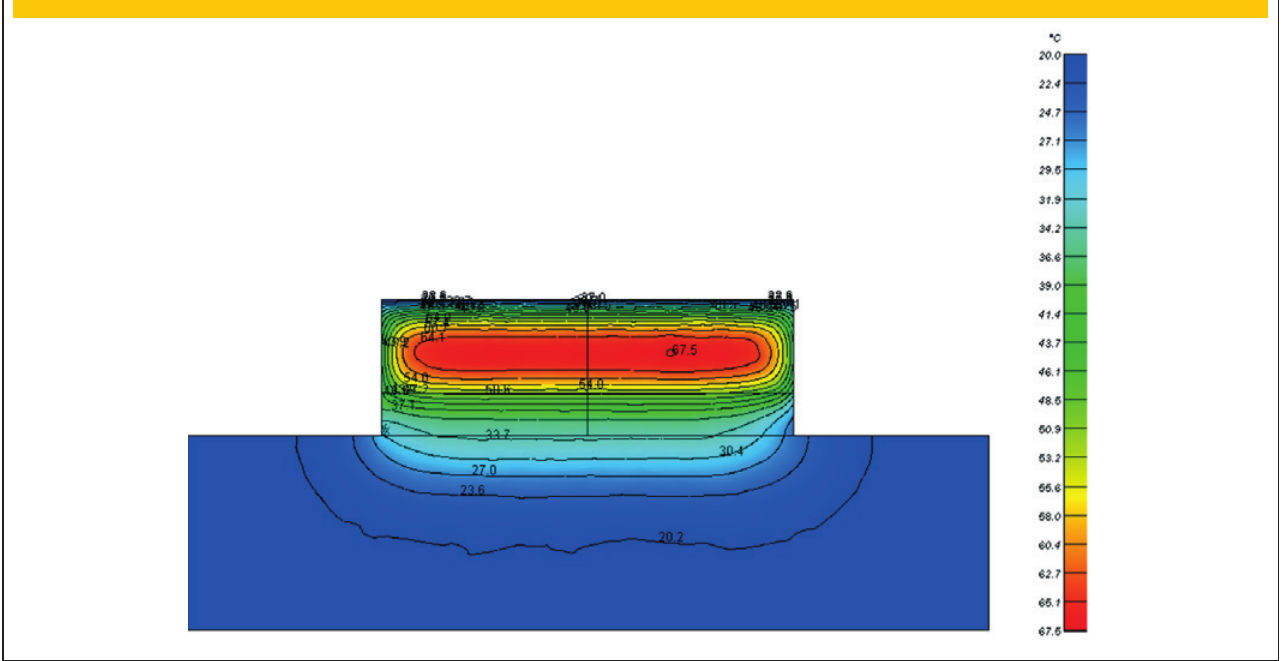
Figure 7 – Isothermals on the central cross-section of the spread footing at the moment of peak temperature in the numerical prediction model (FEM – b4cast